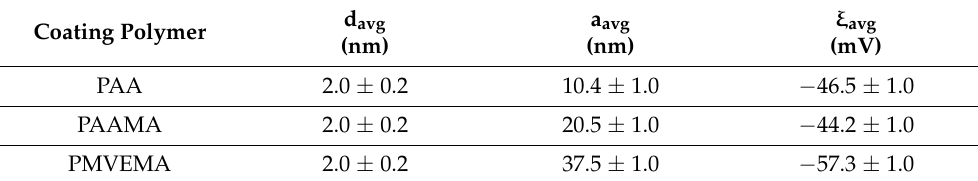
Figure 2. ( a , b ) HRTEM images, ( c ) HAADF-STEM images, ( d ) elemental mapping in HAADF-STEM images, and ( e ) EDS spectra for (i) PAA-, (ii) PAAMA-, and (iii) PMVEMA-coated Pt-NPs. Arrows in ( e ) indicate signals from Pt. ( f ) Particle diameter distributions and log-normal function fits to obtain d avg . ( g ) Hydrodynamic diameter distributions and log-normal function fits to obtain a avg . Table 1. Average particle diameters (d avg ), average hydrodynamic diameters (a avg ), and zeta poten- tials ( ζ avg ) of polymer-coated